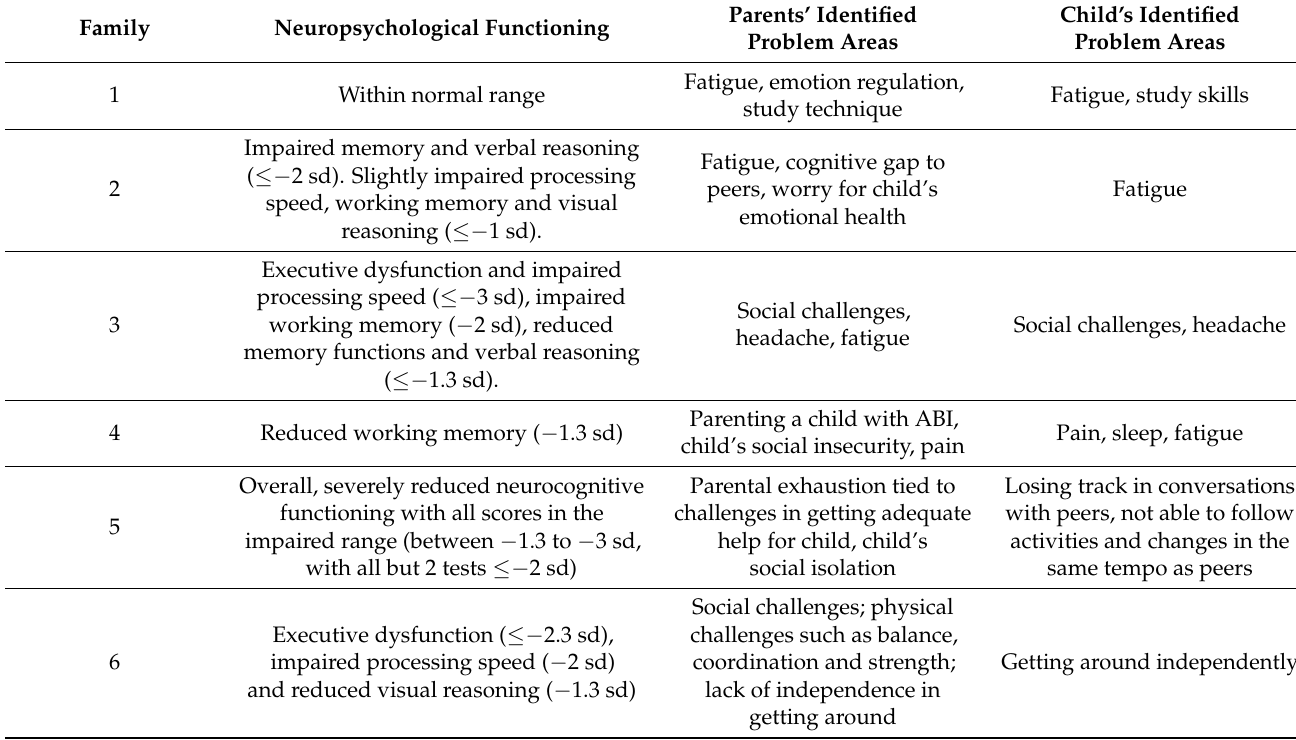
Table 3. Neuropsychological functioning and main pABI-related problem